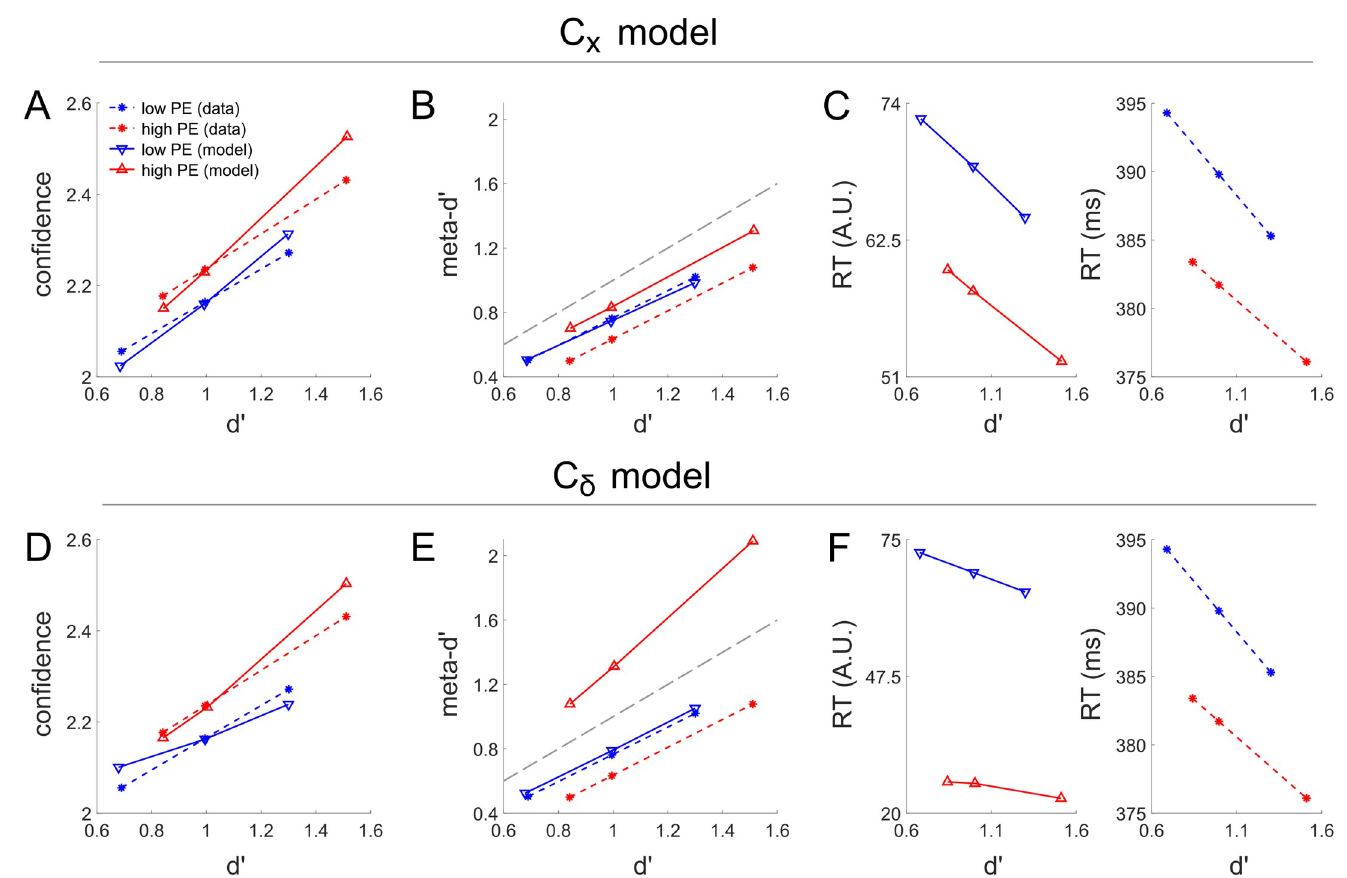
Fig 6. Modeling results for the effects reported by Koizumi and colleagues [10] in their Experiment 2B with parameter values chosen to best capture the effect of PE level on mean confidence (corresponding to the data points shown in black circles in Fig 5). As for their Experiment 1A, the fitted main C x model reproduces the differential confidence for matched d’ performance for high versus low PE stimuli (A) and the relatively overlapping distributions of meta-d’ as a function of d’ (B), although somewhat less well than for experiment 1. However, in contrast to Experiment 1A the main C x model now correctly predicts the relationship between RT differences a s function of d’ and PE (C) much better than for Experiment 1A. In contrast, while the alternative C δ model can reproduce the differential confidence as a function of density level given matched d’ (D), it again badly fails to capture the overlapping relationship between d’ and meta-d’ (E)–this time predicting an implausibly high meta-d’ value. The alternative C δ model also again predicts overly large RT differences as a function of density level, while predicting almost zero impact of d’ on RT (F). Thus, as with Experiment 1A, the main C x model overall produces much closer fit to the data. Note that in the empirical data, there were only two levels of task difficulty; these correspond to the first and last data point in each linear curve in this plot. The second data point in each curve corresponds to the mean d’ across difficulty levels in the Low PE condition, which was used for model fitting purposes (see Methods for